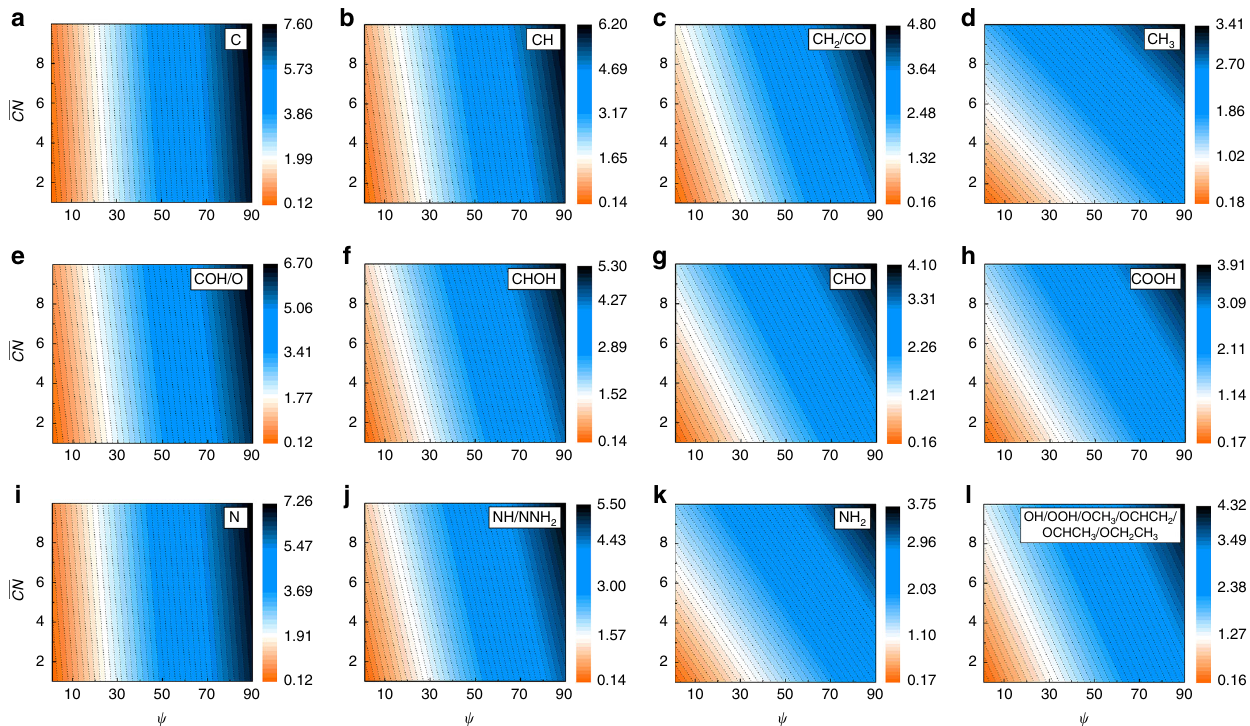
Fig. 8 Variation of adsorption energy as a function of the electronic descriptor ψ and generalized coordination number CN . a C atom. b CH radical. c CH 2 radical or CO molecule. d CH 3 radical. e COH radical or oxygen atom. f CHOH radical. g CHO radical. h COOH radical. i N atom. j NH radical or NNH 2 radical. k NH 2 radical. l OH radical, OOH radical, OCH 3 radical, OCHCH 2 radical, OCHCH 3 radical, or OCH 2 CH 3 radical. This two-dimensional (2D) mapping is obtained from Eq. (7). The contours and gradients account for the ef fi ciency of modulating the electronic nature and geometric structure